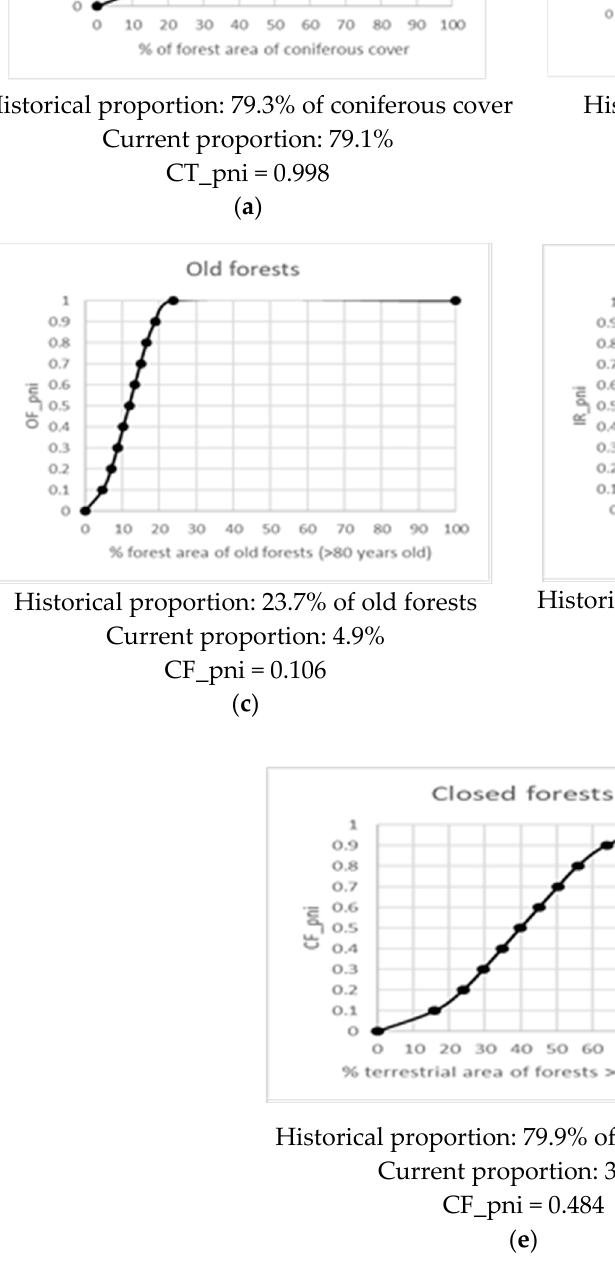
Figure A2. Curves determining the potential naturalness index to evaluate the condition indicators (condition_pni) for FM-A using local studies for reference data: ( a ) coniferous cover type; ( b ) late successional characteristic species; ( c ) old forests; ( d ) irregular stands; ( e ) closed forests.